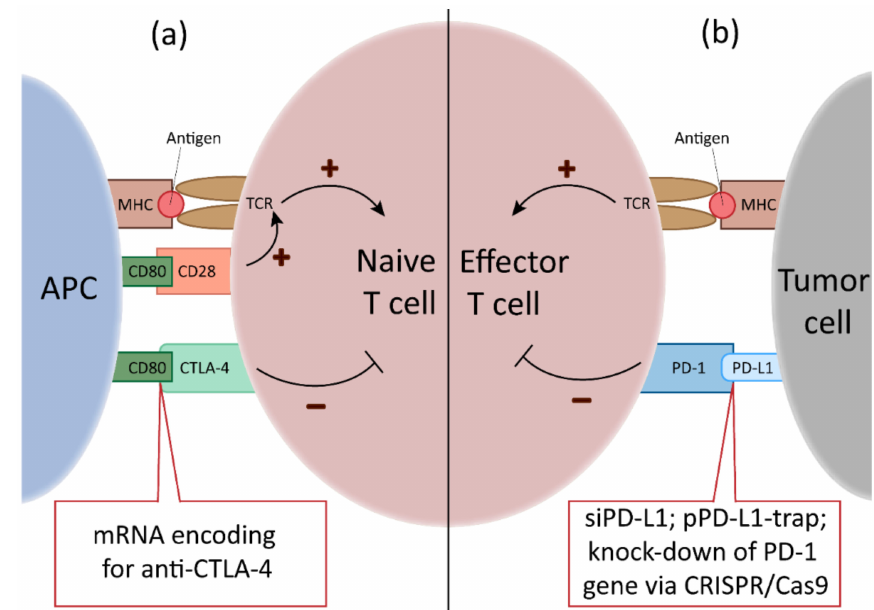
Figure 3. Immune checkpoint inhibition mediated by nucleic acid-based strategies. ( a ) Besides recognition of major histocompatibility complex (MHC)-bound antigen on the surface of APC via TCR, co-stimulatory signals—inter alia interaction of CD80 (B7-1) and CD28—are required for full T cell activation. The duration and intensity of activation is regulated among other things by immune checkpoint CTLA-4 that binds with high a ffi nity to CD80. Blocking of this interaction results in enhanced T cell activity. One therapeutic option is delivery of mRNA encoding for anti-CTLA-4 antibodies. ( b ) Tumor cells often upregulate PD-L1 that binds to PD-1 on e ff ector T cells, thereby inhibiting the activity of e ff ector T cells. Nucleic acid-based approaches for blocking this immune checkpoint comprise siRNA against PD-L1, pDNA encoding for PD-L1 trap proteins (pPD-L1-trap), and CRISPR / Cas9-mediated knock-down of PD-1